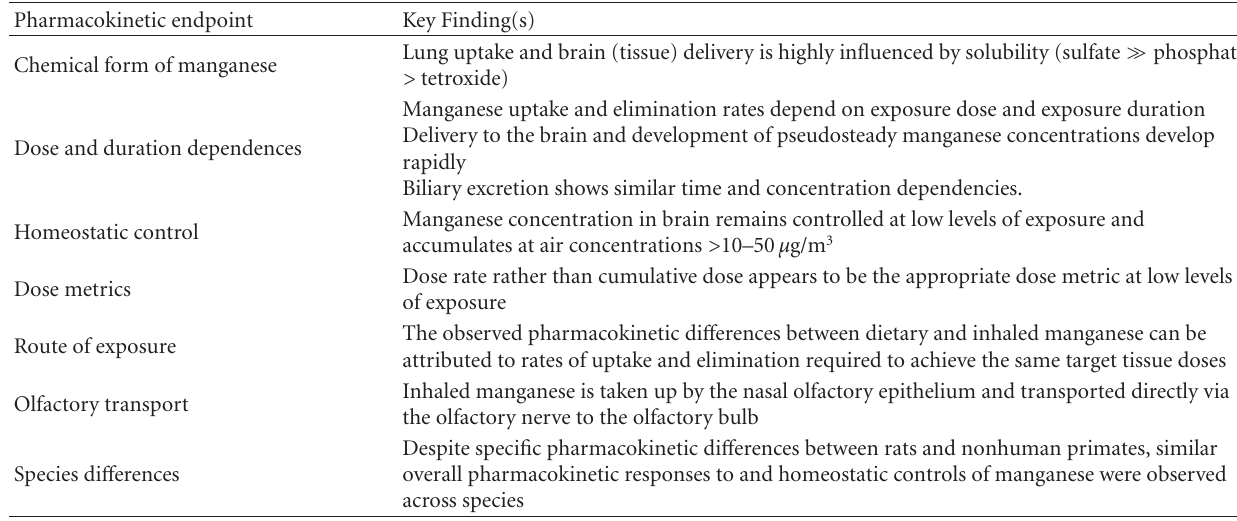
Table 2: Notable scientific contributions derived from the MMT Alternative Tier 2 test